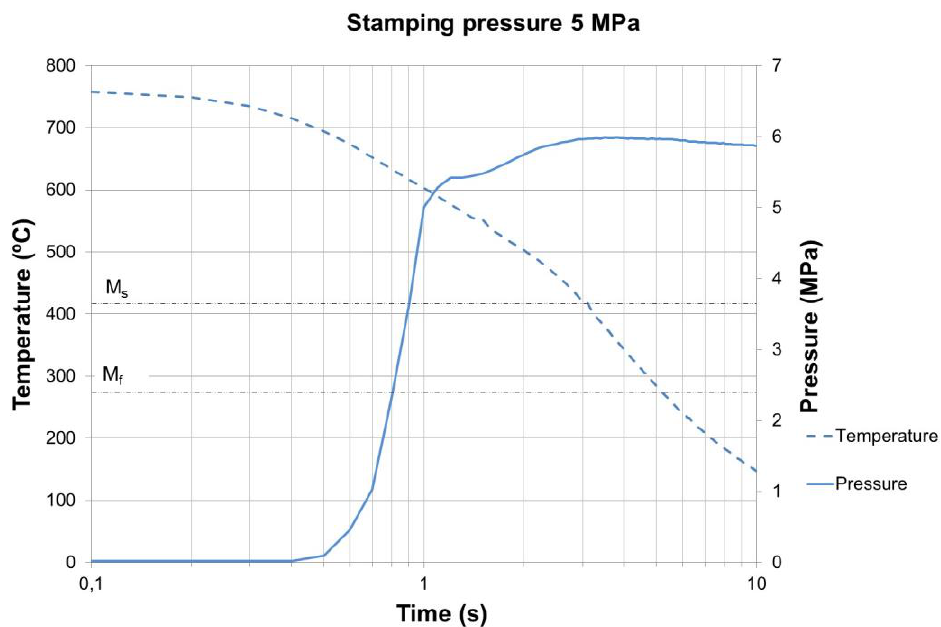
Metals 2018 , 8 , x FOR PEER REVIEW Figure 13. Temperature–pressure–time plot for a pressure set-point of 5 MPa. Figure 13. Temperature–pressure–time plot for a pressure set-point of 5 MPa.